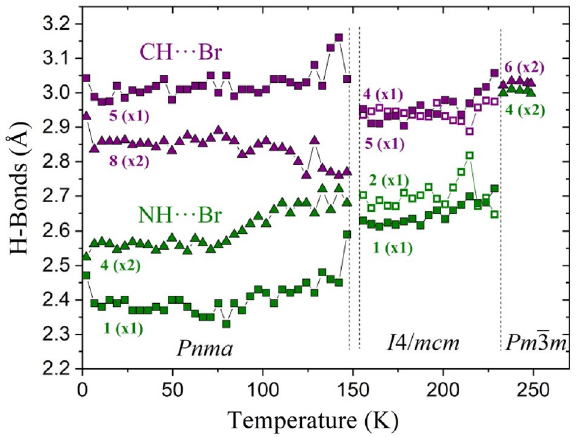
Figure 13. Thermal evolution of H-bond distances in the 2–250 K temperature range. The NH···Br and NH···Br bonds are plotted in green and purple colours, respectively. The single and twofold H-bond interactions are plotted with squares and triangles,